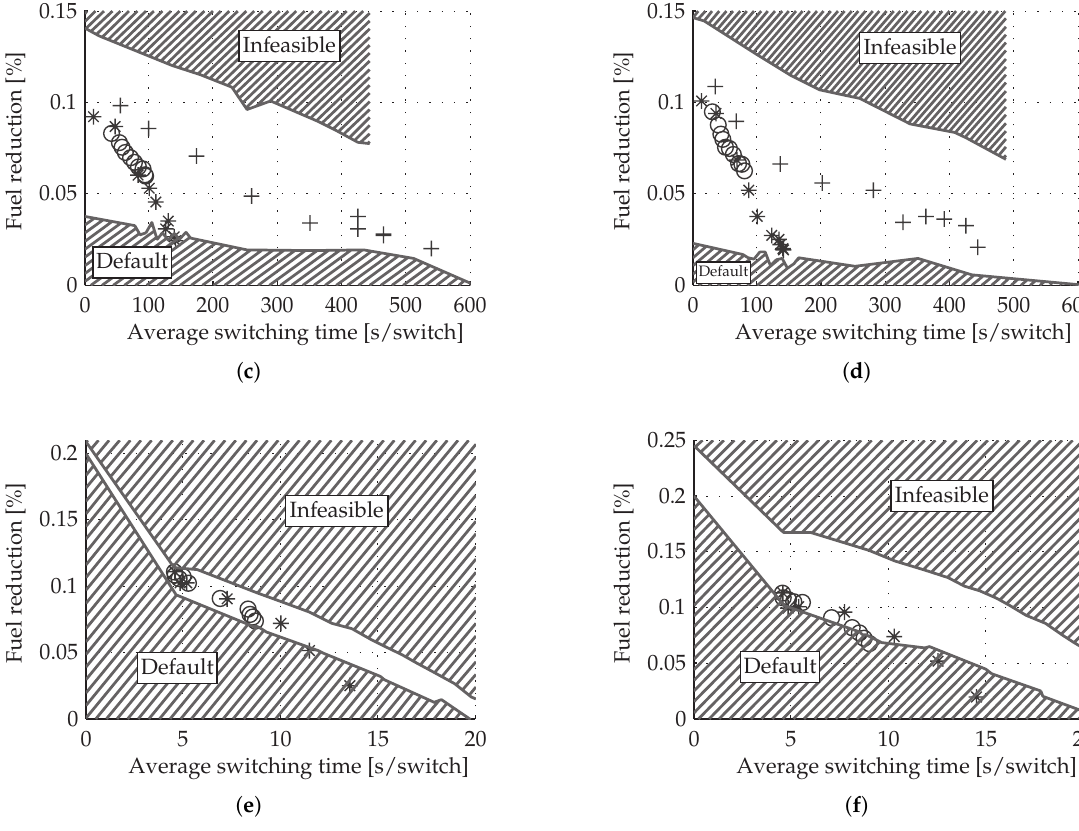
Figure 7. Fuel reduction with real-time on/off control of the refrigerated semi-trailer, the air supply system and the climate control system for three different switching strategies. ( a ) Refrigerated semi-trailer, Part 1; ( b ) Refrigerated semi-trailer, Part 2; ( c ) Air supply system, Part 1; ( d ) Air supply system, Part 2; ( e ) Climate control system, part 1; ( f ) Climate control system, Part